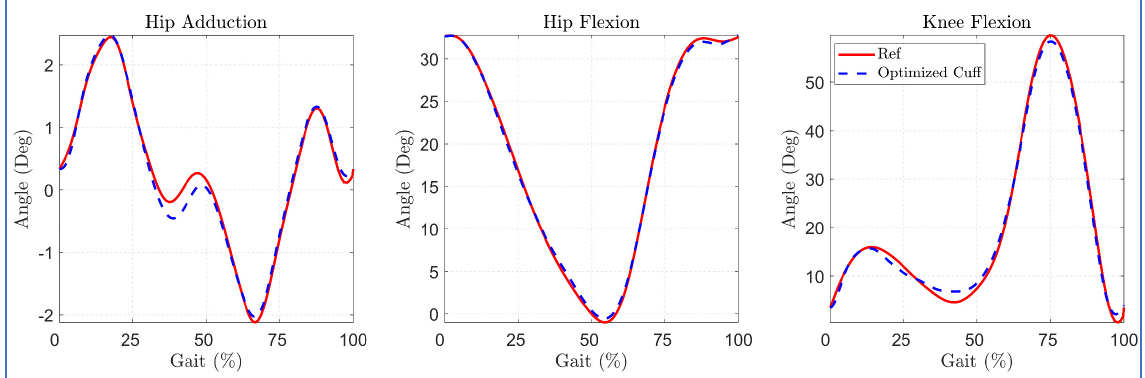
Figure 8. Trajectory tracking with case (II) optimized cuff configuration.